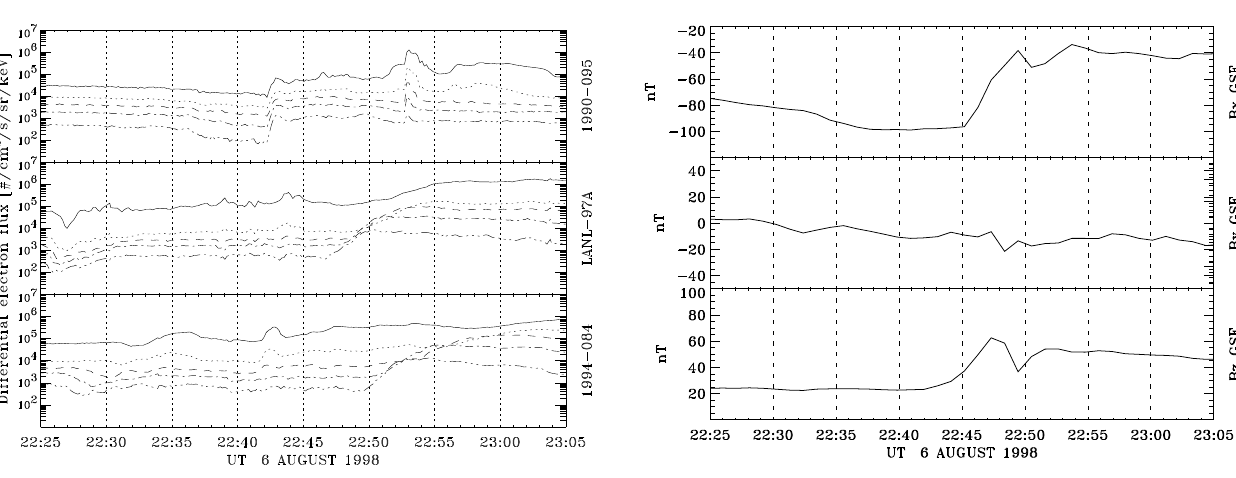
MLT midnight region coincident with a sudden, large change